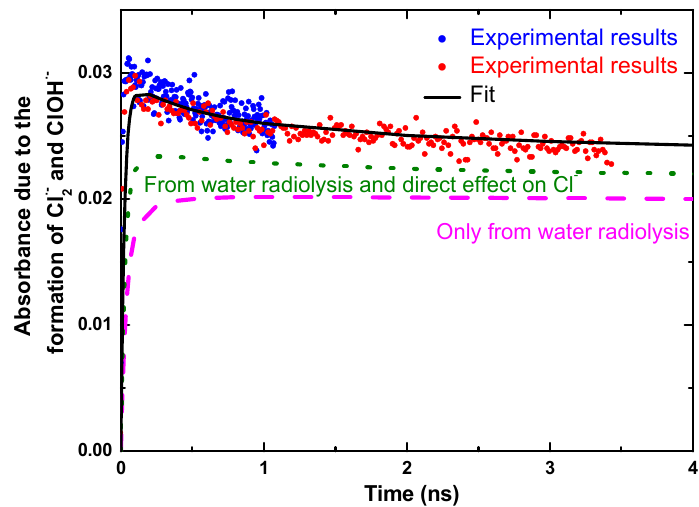
Figure 5. Observed absorbance decay (blue and red data for short and long time scale) in solution containing 5.5 M NaCl with model simulations of spur reactions: (dashed line) simple water model alone without any direct effect; (dotted line) with direct ionization of Cl − ; (solid line) with direct ionization of Cl − and 30% scavenging of H 2 O • + by Cl − . The dose was 22.5 Gy per pulse. Adapted from